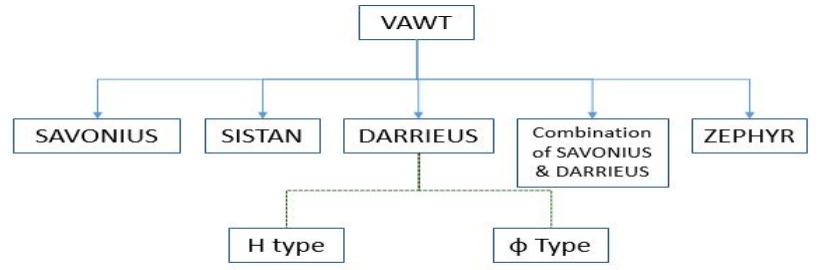
Figure 1. Classification of vertical axis wind turbines [22]. Table 2. Summary of techniques to design efficient vertical axis wind